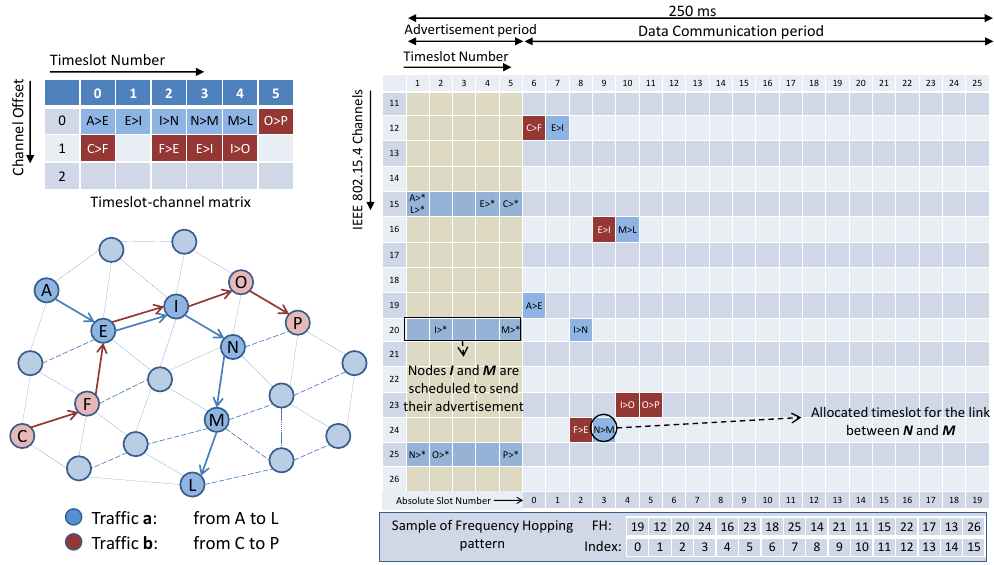
Figure 6. Modified